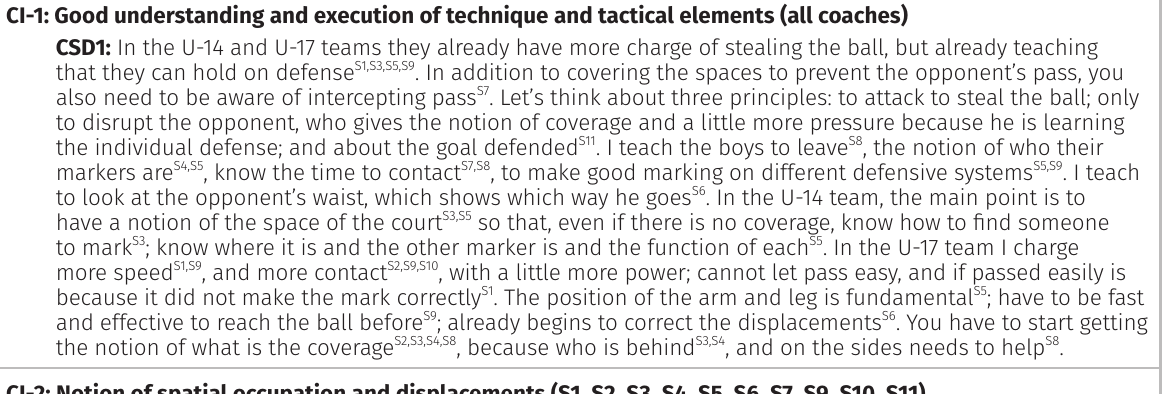
Table II. CSD of the individual defensive contents considered most important by the coaches in the U-14 and U-17